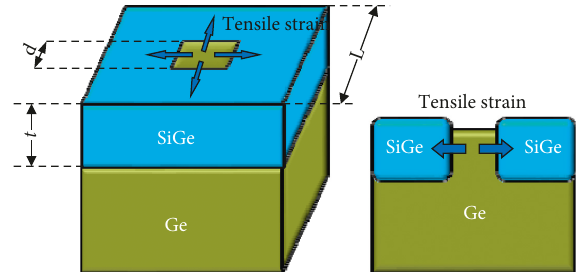
Figure 7: Local 3D structure and profile of selective epitaxy-in- duced direct band gap Ge